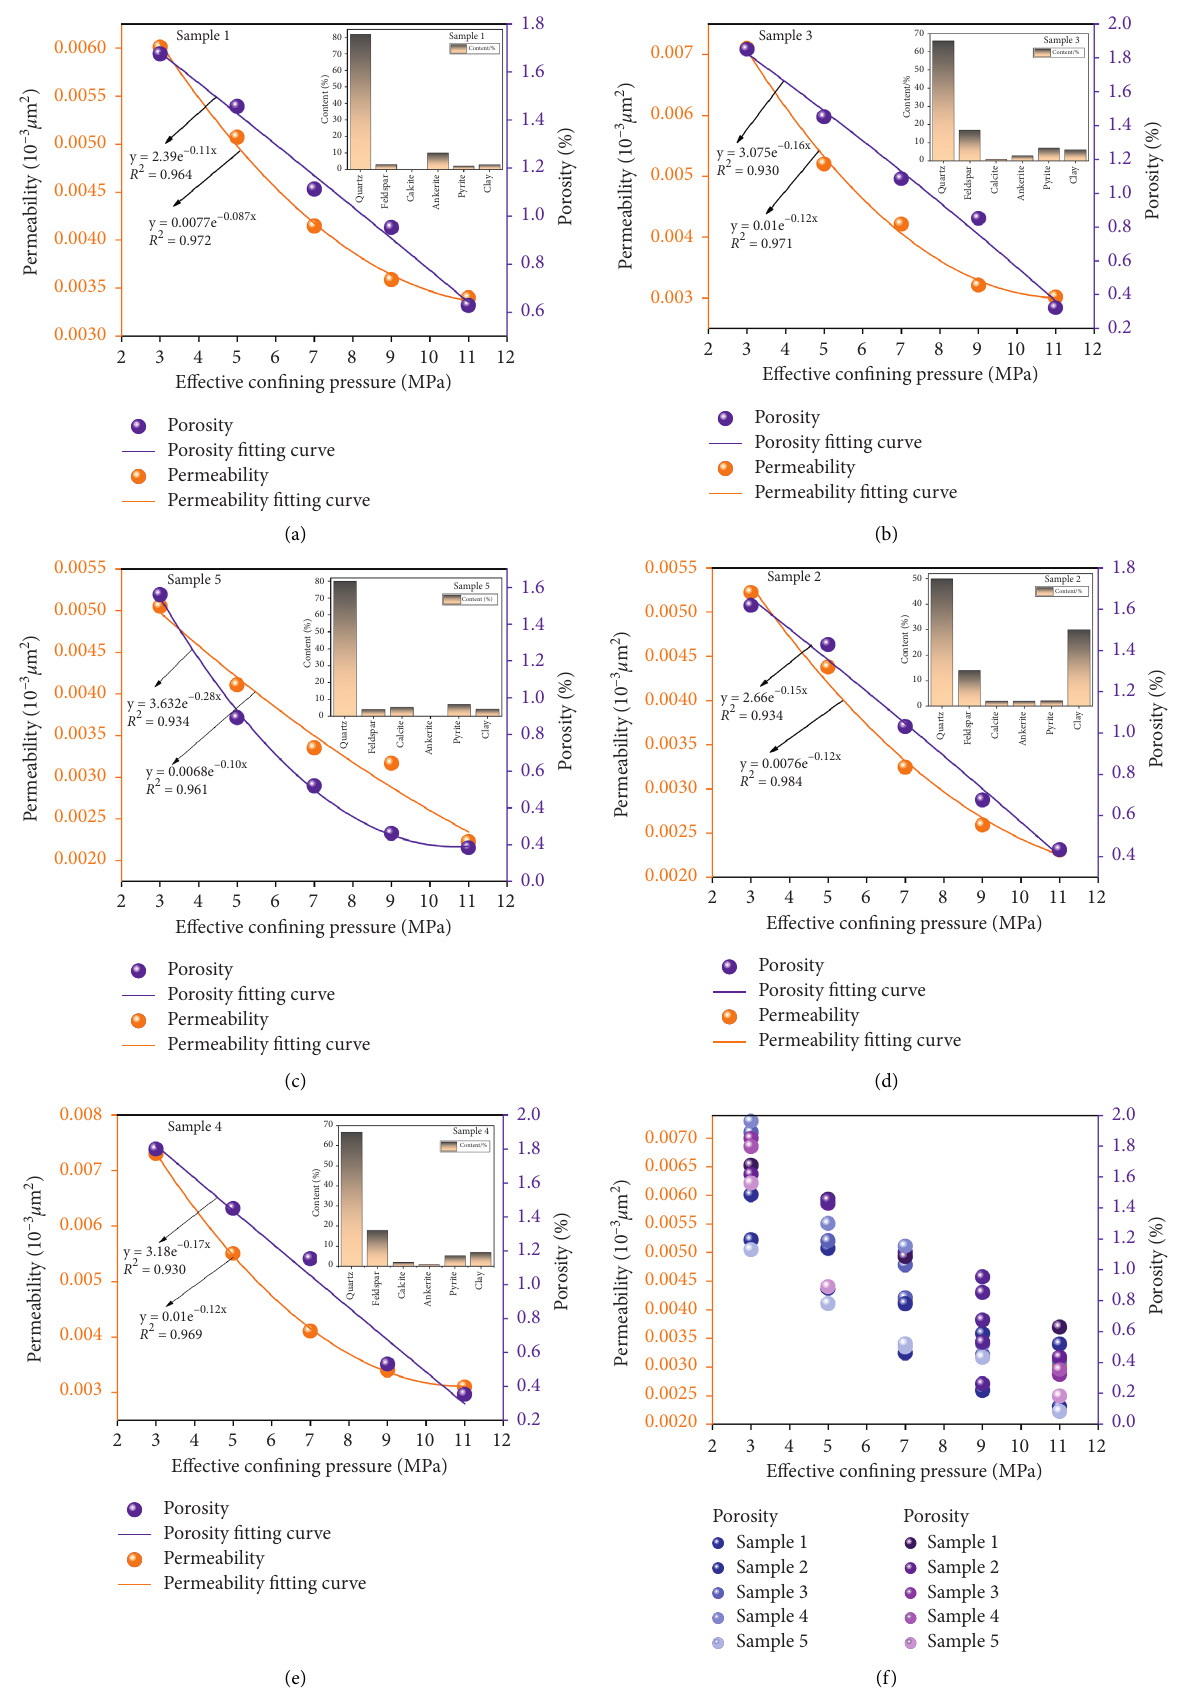
Figure 4: Variation in shale permeability and porosity under different effective